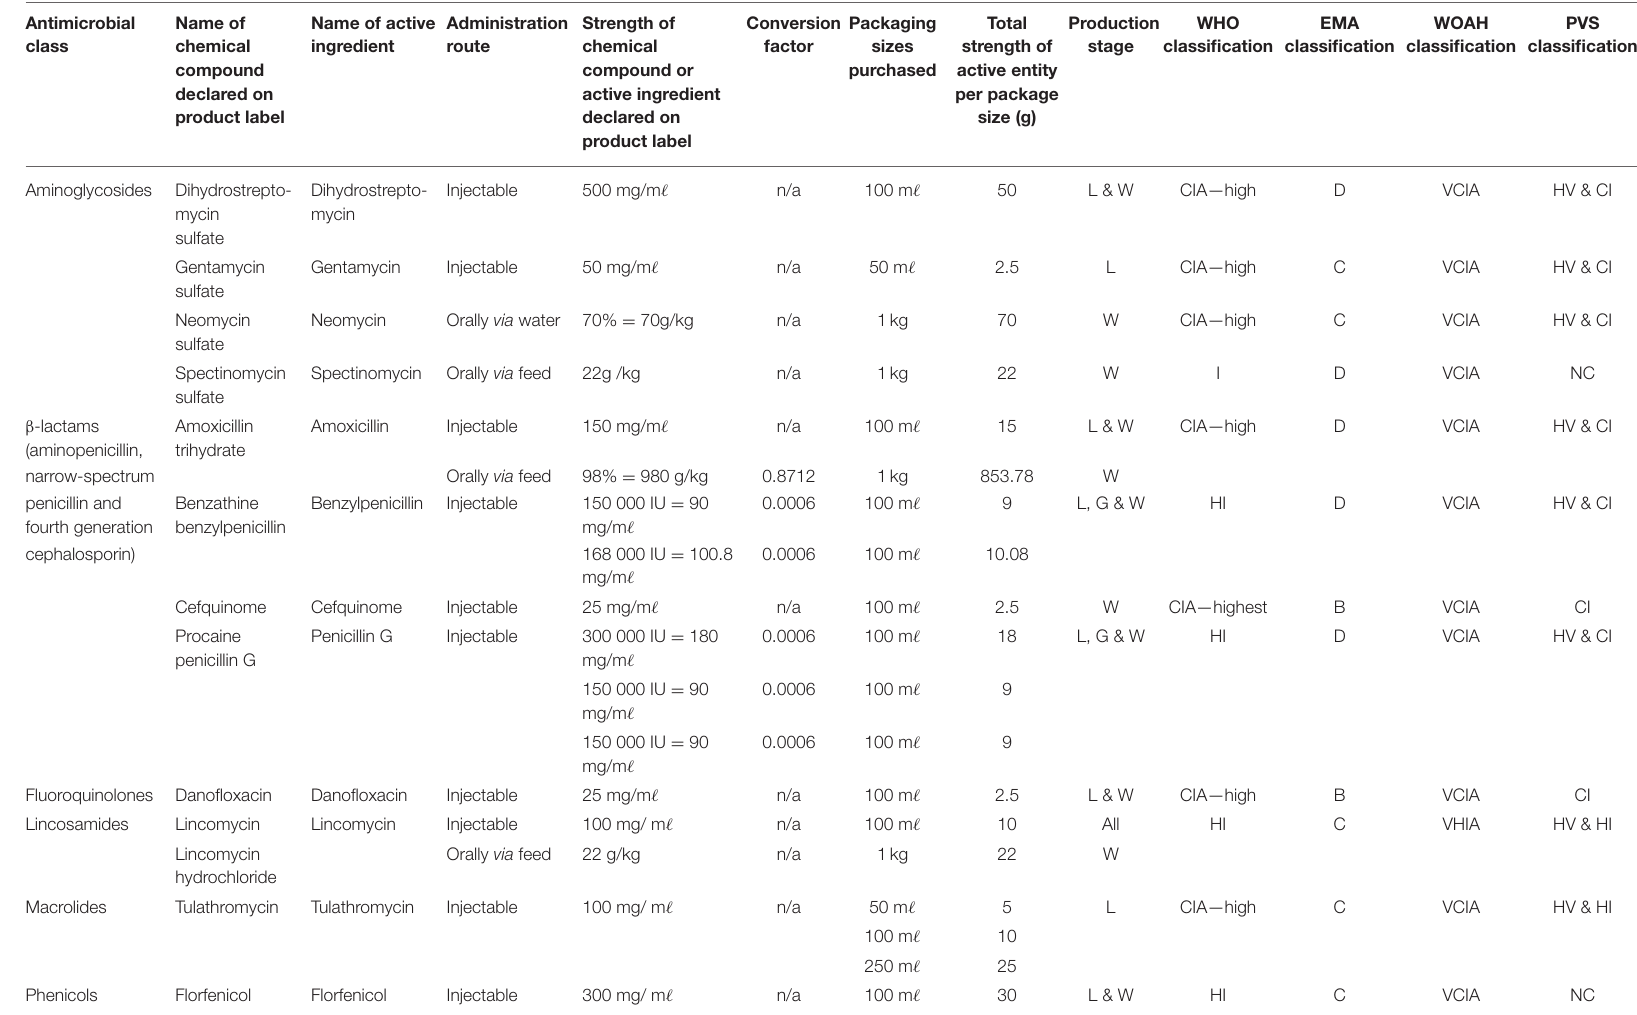
TABLE 1 | Summary of product characteristics (SPC) of antibiotics identified from invoices in a commercial pig farm. Antimicrobial